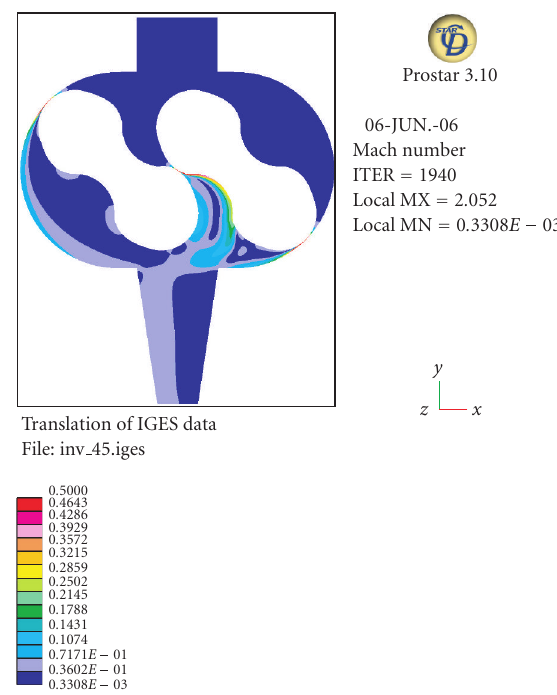
Figure 8: Mach number contours for full machine.